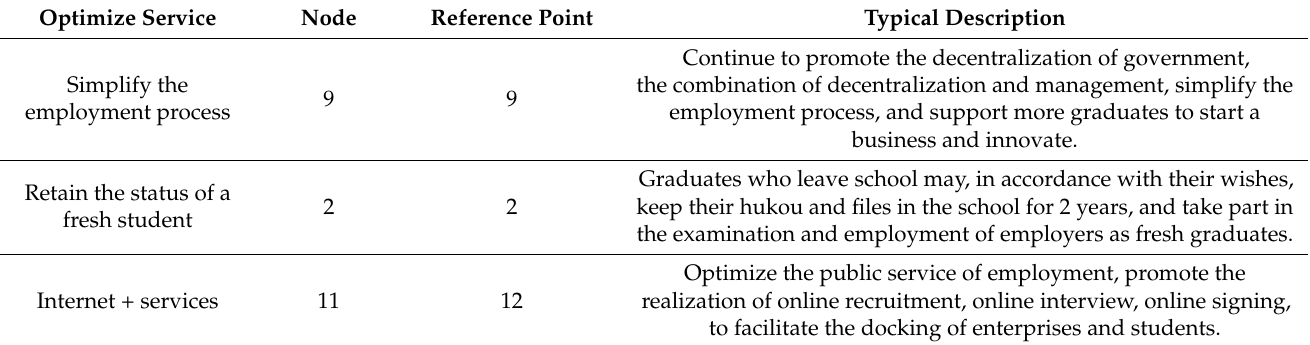
Table 4. Optimizing public